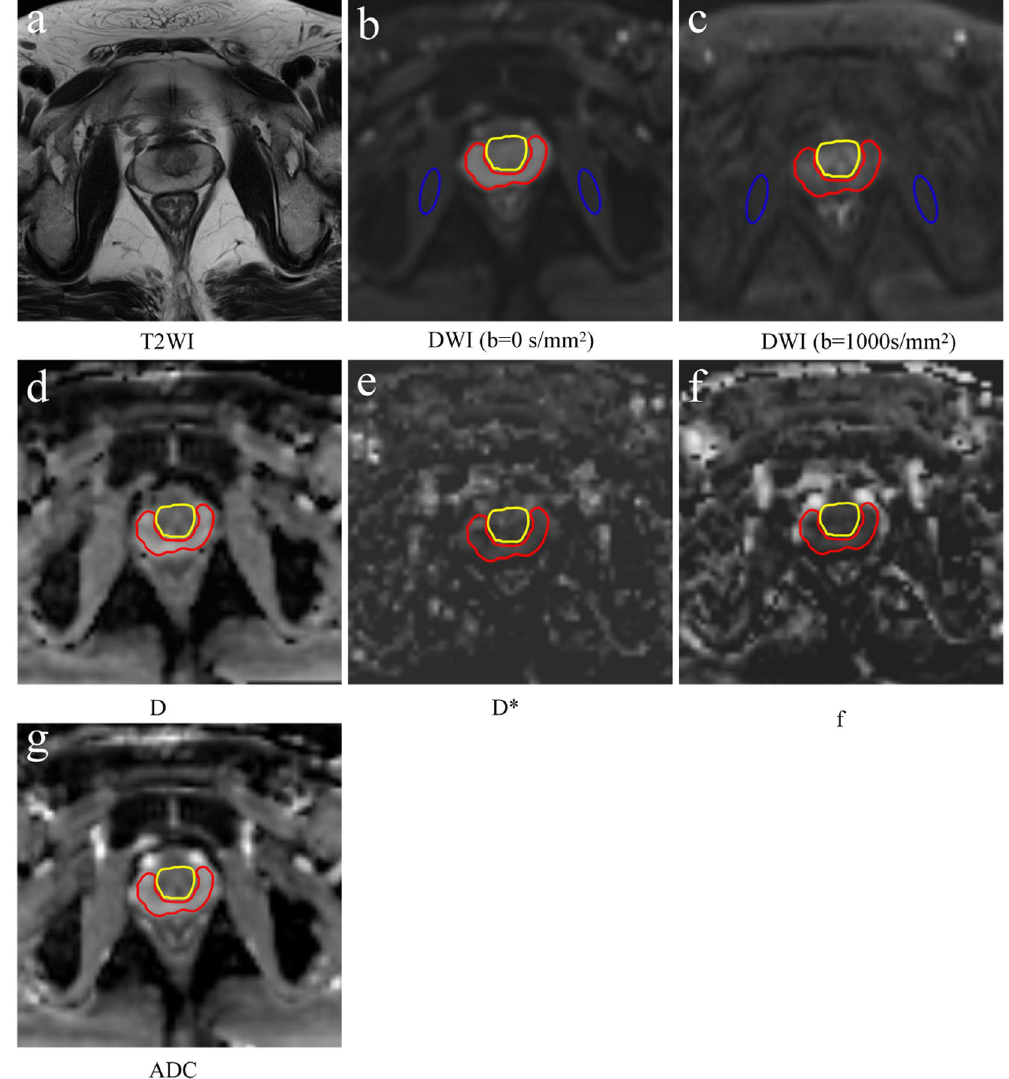
Figure 2. ROI drawing method. ( a ) Axial T2WI, ( b ) Axial DWI with TE = 60 ms and a b value of 0 s/mm 2 . The ROI was drawn within the outer border of the central zone (yellow solid line) and peripheral zone (red solid line). Then, the ROI was automatically copied to each parameter map. The oval ROI was drawn on the bilateral obturator muscle and automatically copied to an image with a b value of 1000 mm 2 /s ( c ) to measure the signal- to-noise ratio. ( d – g ) Parameter maps of D, D * , f and ADC, respectively, calculated by DWI with TE = 60